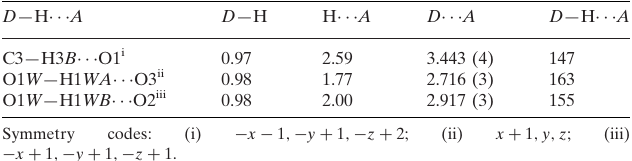
Hydrogen-bond geometry (A˚ , (cid:3)